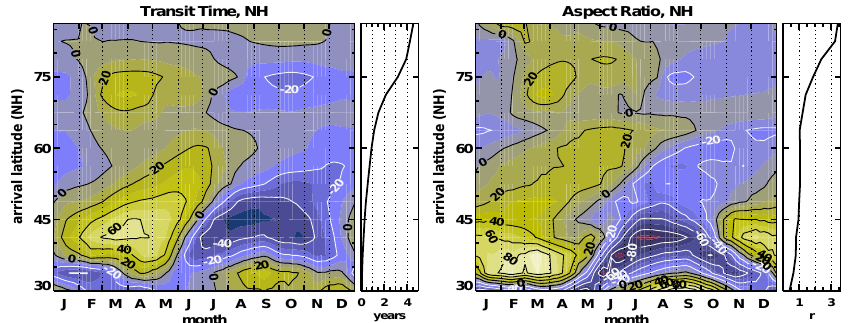
Fig. 7. Annual cycles of residual circulation transit times (left) and of trajectory vertical to horizontal aspect ratio r (right) for northern hemispheric extratropics as a function of arrival latitude for CMAM (plotted are percentage deviations from annual mean). Arrival pressure is set to correspond to Θ TP +30 K. Annual mean curves are shown in the small right-hand panels (dotted lines mark integer values).